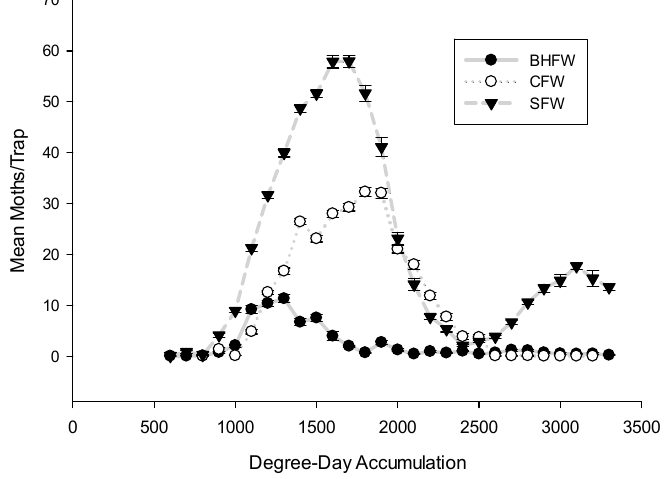
Figure 2. Flights of cranberry fruitworm (CFW), sparganothis fruitworm (SFW), and blackheaded fireworm (BHFW) averaged across all three major growing regions of Wisconsin.